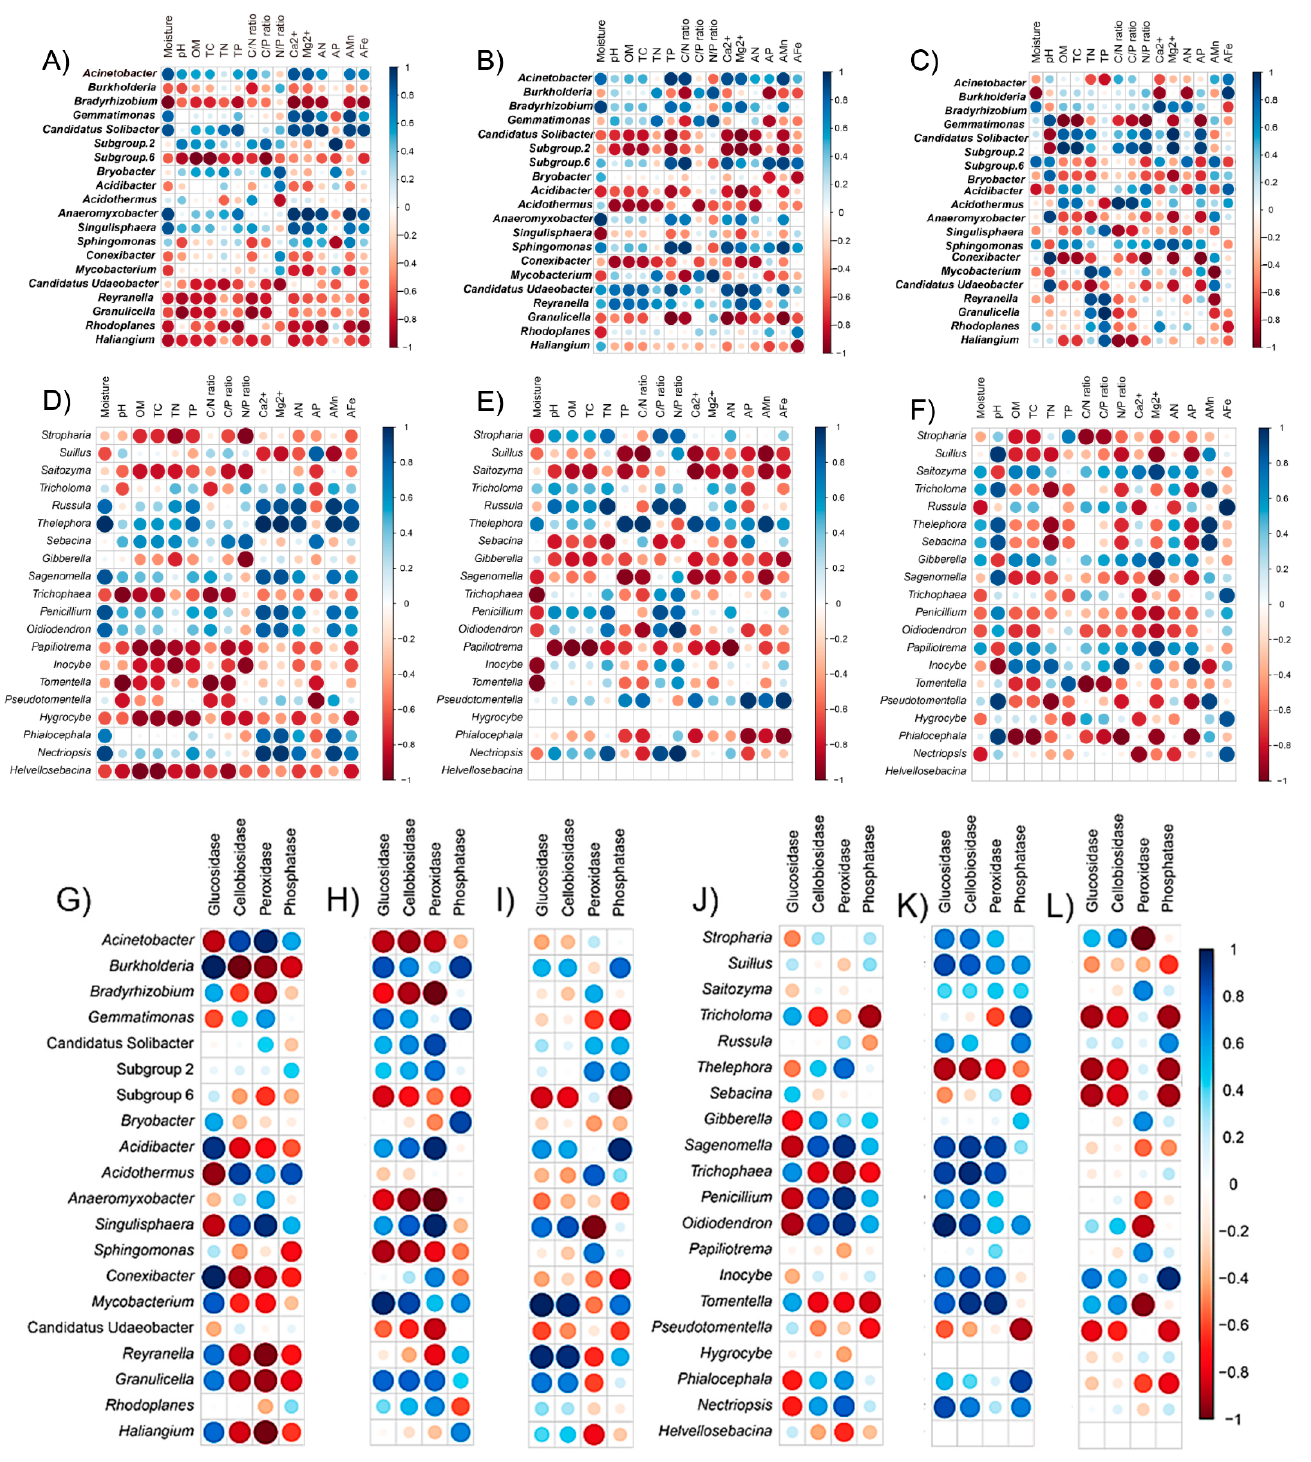
Figure 9. Spearman correlations between the dominant bacterial ( A – C , G – I ) and fungal taxa ( D – F , J – L ) and soil properties with low ( B , E , H , K ) and strong ( C , F , I , L ) influence of Stropharia rugosoannulata cultivation and control ( A , D , G , J ) soils, respectively. For clarity purposes, relationships between enzymatic activities and dominant microbial taxa are shown on the lower part of the figure ( G – L ). Size of circles in plot cells is proportional to correlation coefficients (Spearman’s p ). Strength and direction of the correlations are denoted by circle size and color (as per scale bar). The scale bar extends from perfect correlation (dark blue, r = 1, dark red, r = − 1). Large circles also denote a stronger correlation. Abbreviations of soil properties correspond to those described in Tables 1 and 2.